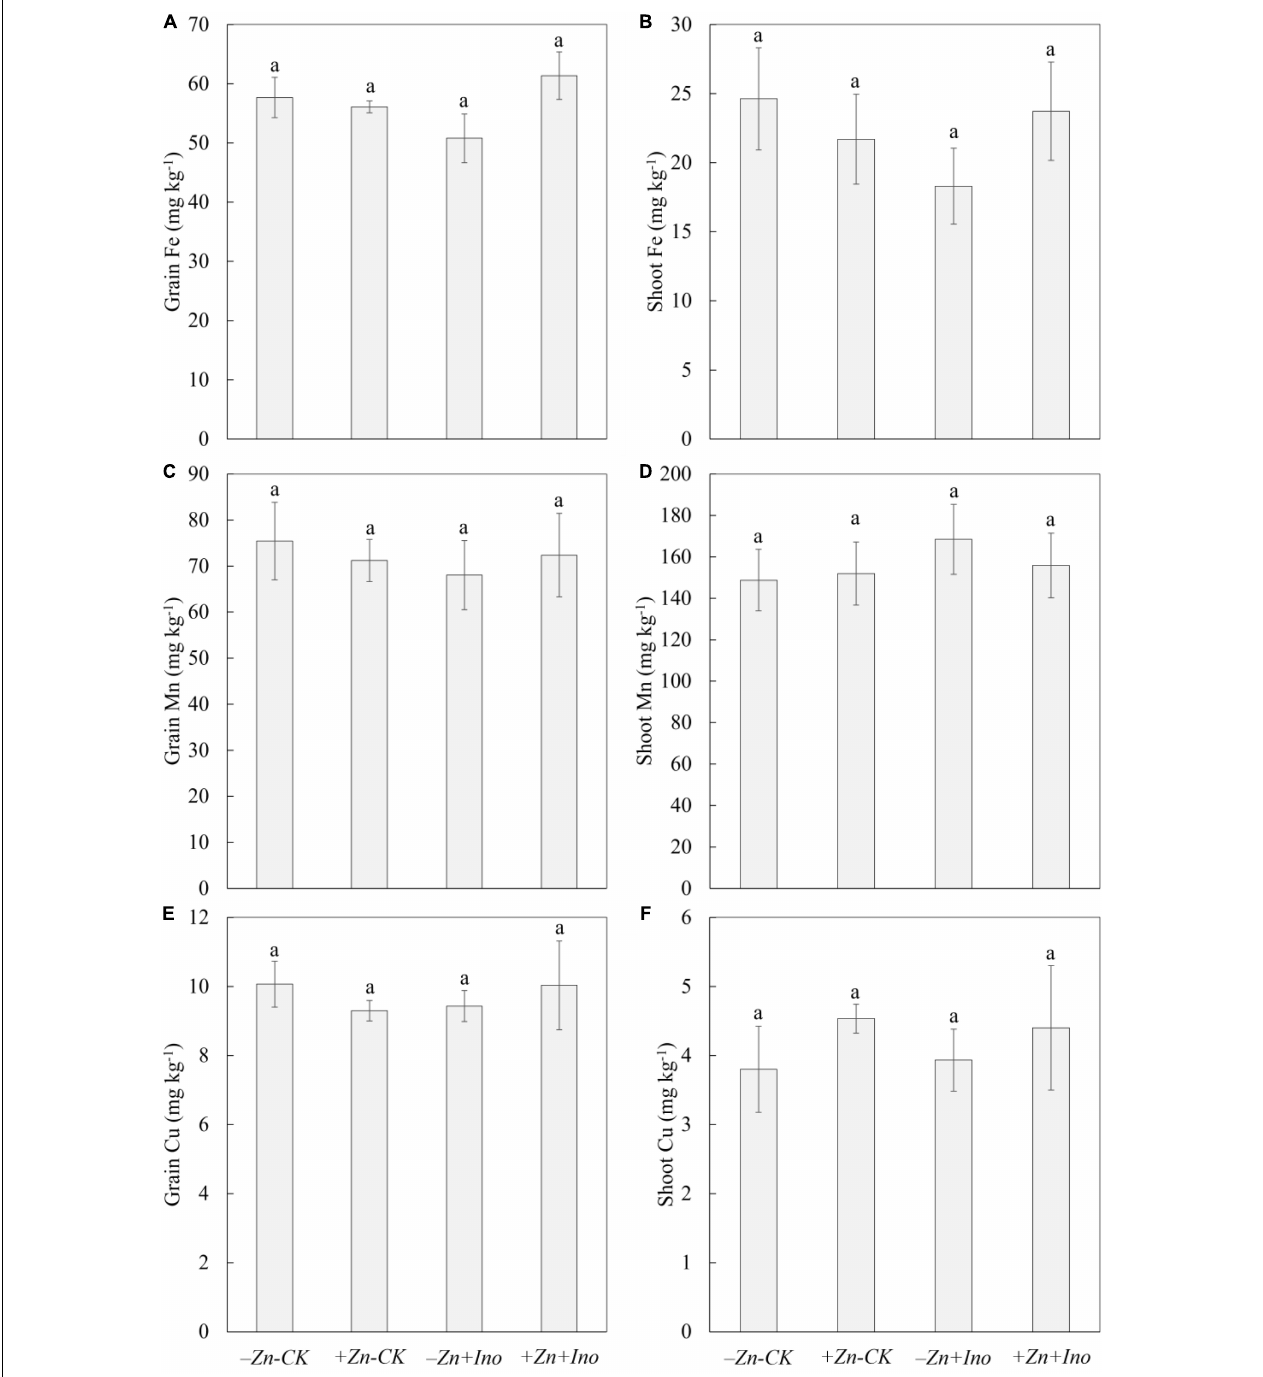
FIGURE 5 | Concentrations of Fe (A,B) , Mn (C,D) , and Cu (E,F) in leaves and grains of wheat plants treated with different foliar fertilizers. Data points and error bars represent means and SE of four replicates ( p < 0.05, n =